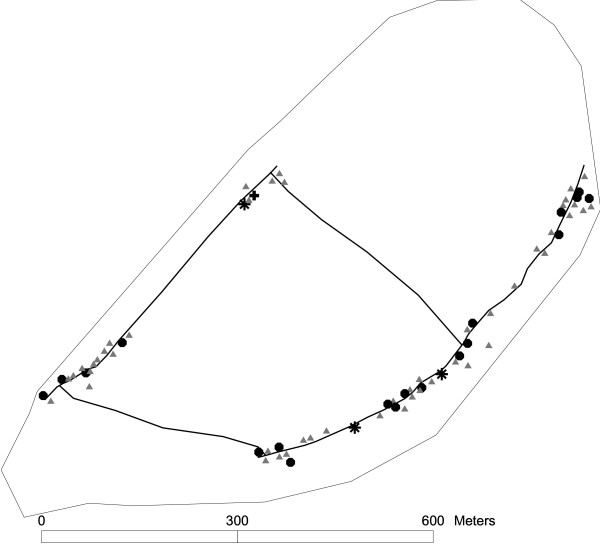
Map of Kembanglemari Island showing the new patients per house.  = 0, ● = 1,  = 2, + = 3 new patients. Not all houses without patients are shown.